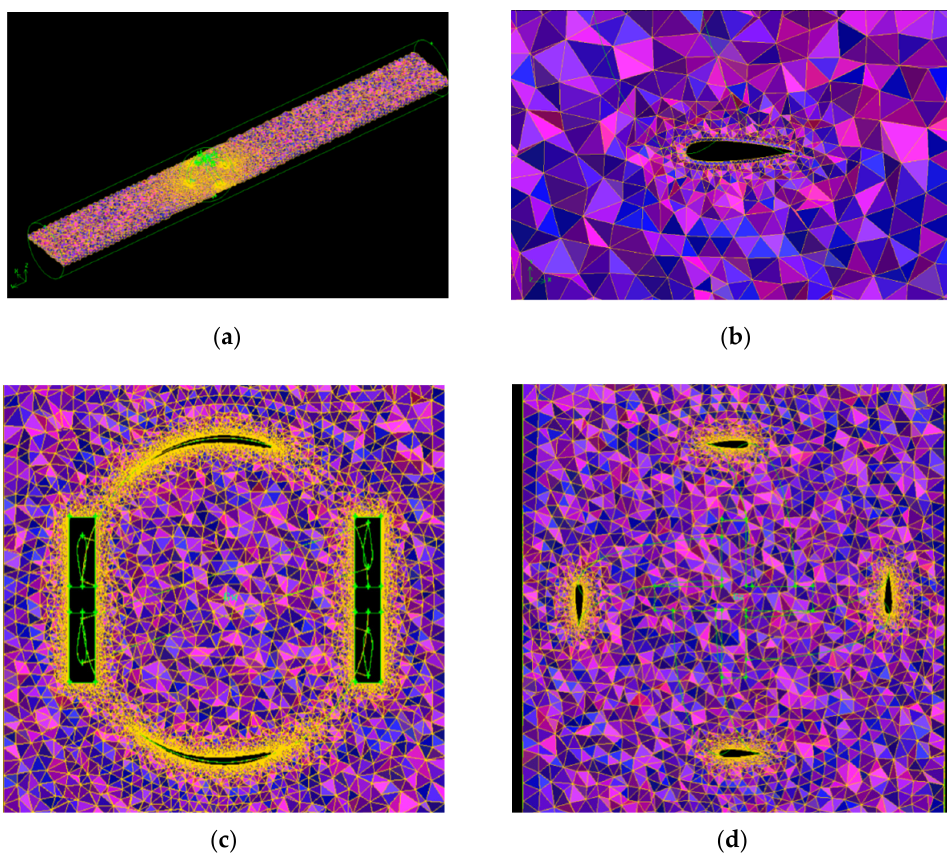
Figure 11. ( a ) Mesh of the turbine and surrounding space around the turbine; ( b ) mesh of a single blade of the turbine; ( c ) static mesh of fluid around turbine in lateral view; ( d ) static mesh of fluid around turbine in top view.